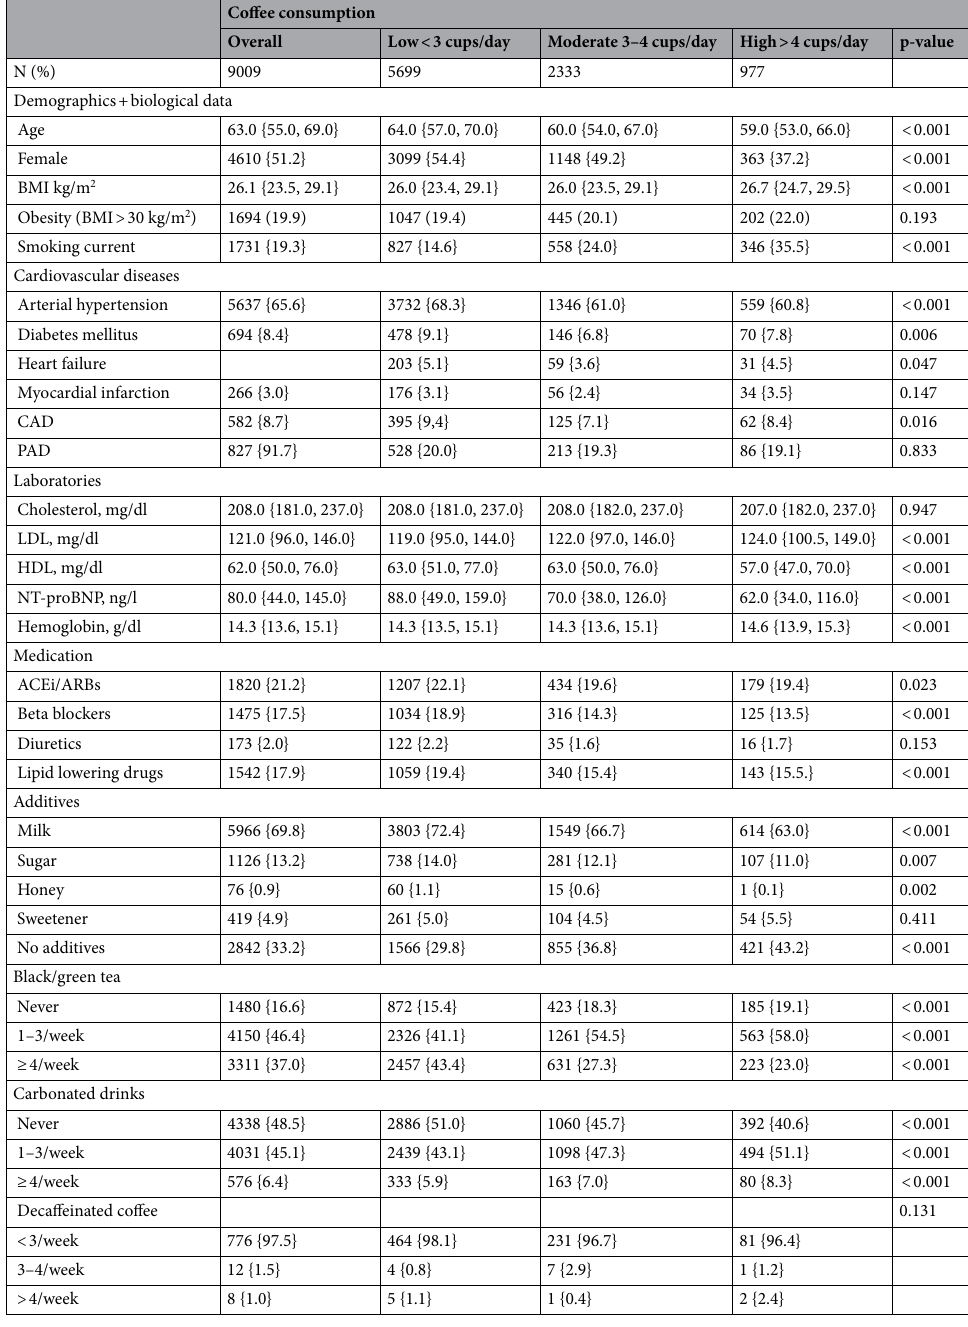
Table 1. Baseline characteristics of the study population. Continuous variables are presented as median and interquartile range, and categorical variables are presented as absolute numbers and percentages.